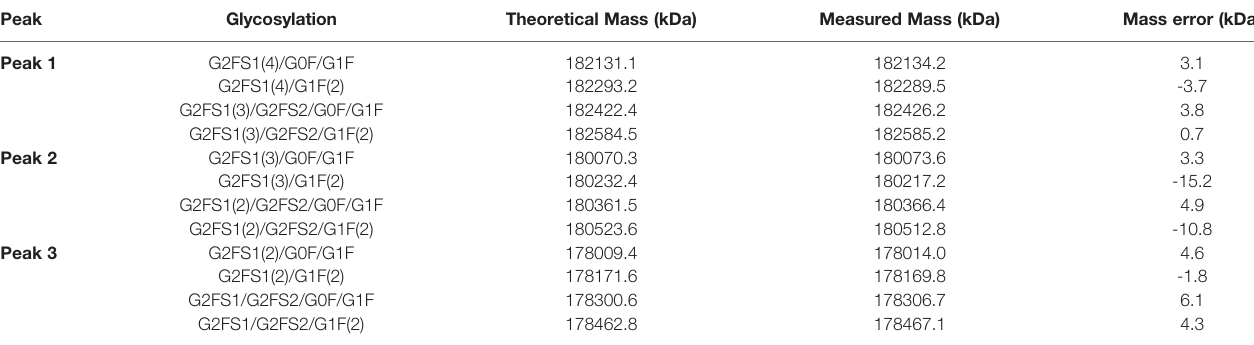
TABLE 2 | Theoretical and measured mass of intact HB0025.